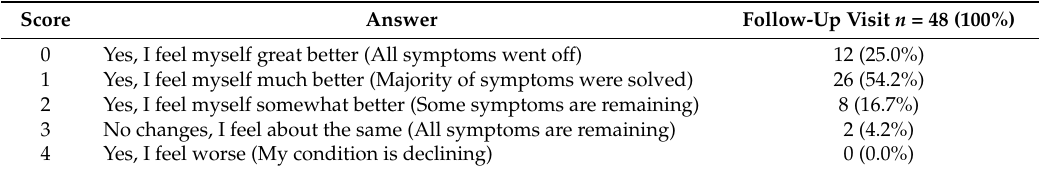
Table 1. Answers from 48 female patients at follow-up visit in the “Dynamics” domain of part B of the Acute Cystitis Symptom Score (ACSS)